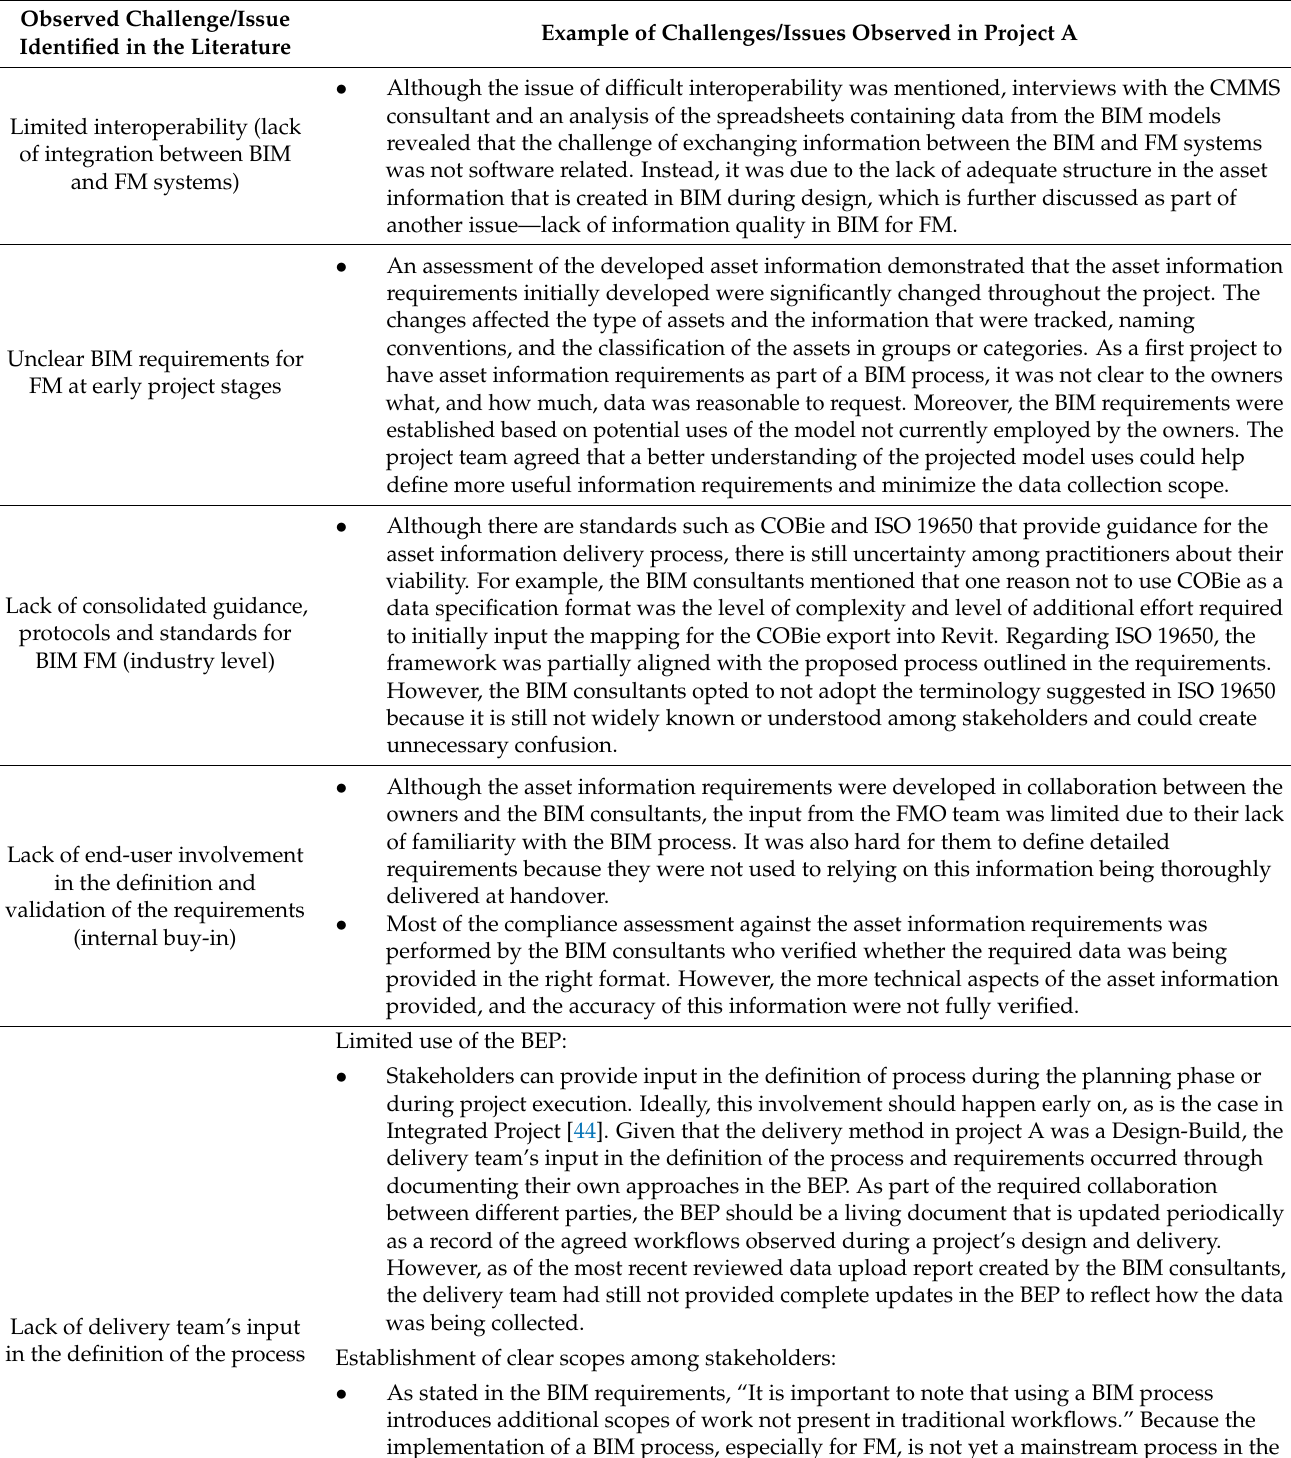
Table 5. Synthesis of challenges identified in the literature with examples and description of how they were observed in